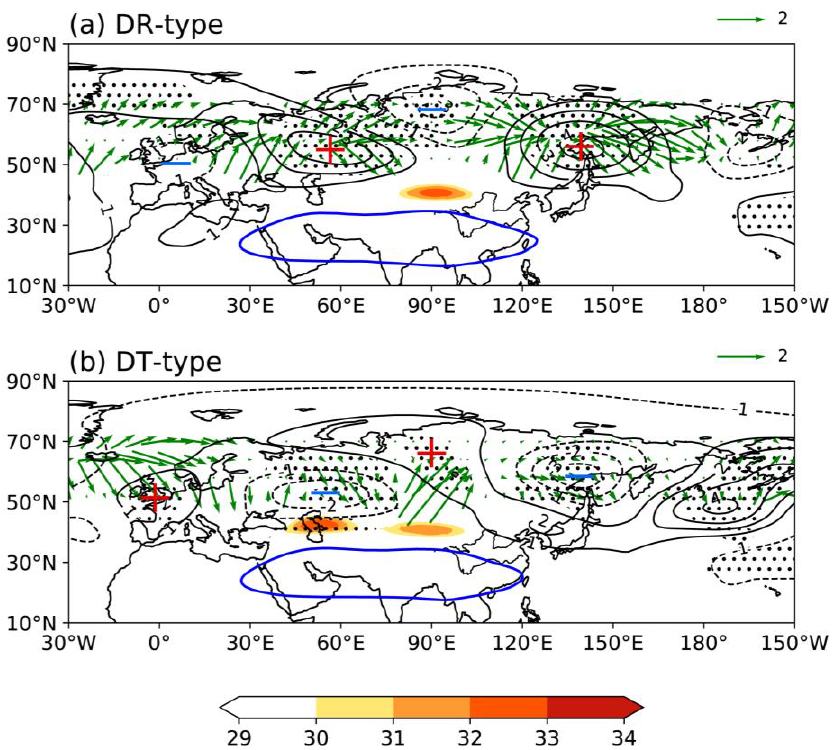
Figure 2. Composite summer geopotential height anomalies at 200 hPa (contours, units: dagpm), zonal wind at 200 hPa (shading, units: m · s − 1 ) and wave activity fluxes (vector, units: m 2 · s − 2 ) for ( a ) DR-type and ( b ) DT-type. The blue solid line (1250 dagpm) indicates SAH and the shading indicates EAJS. The 200 hPa geopotential height anomalies and 200 hPa zonal wind significant at the 90% confidence level are dotted.